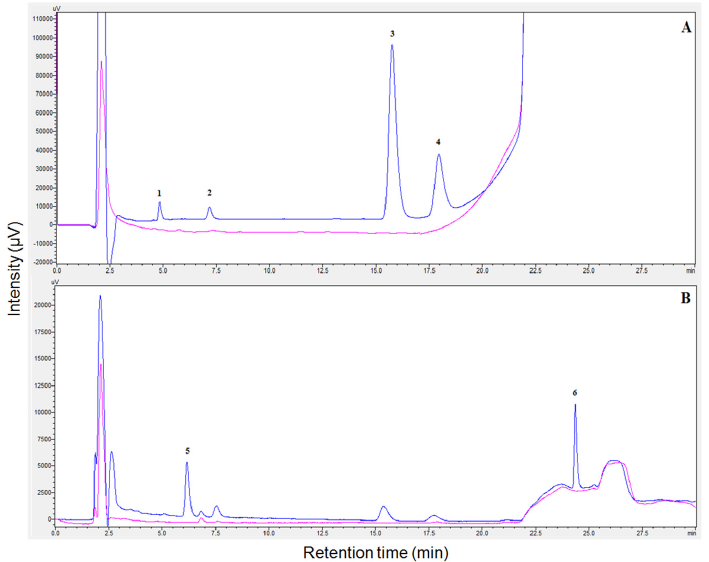
Figure 7. Comparison between the extractions performed in hospital wastewater B without spiking (pink line) and with spiking (blue line) with the analytes. ( A ) comparison using FLD detector with sample spiked with 10 μ g L − 1 of 1-FLU, 2-LOS, 3-NAP, and 4-EE2. ( B ) comparison using DAD detector at 280 nm with sample spiked with 100 μ g L − 1 of 5-CBZ and 6-DCL.